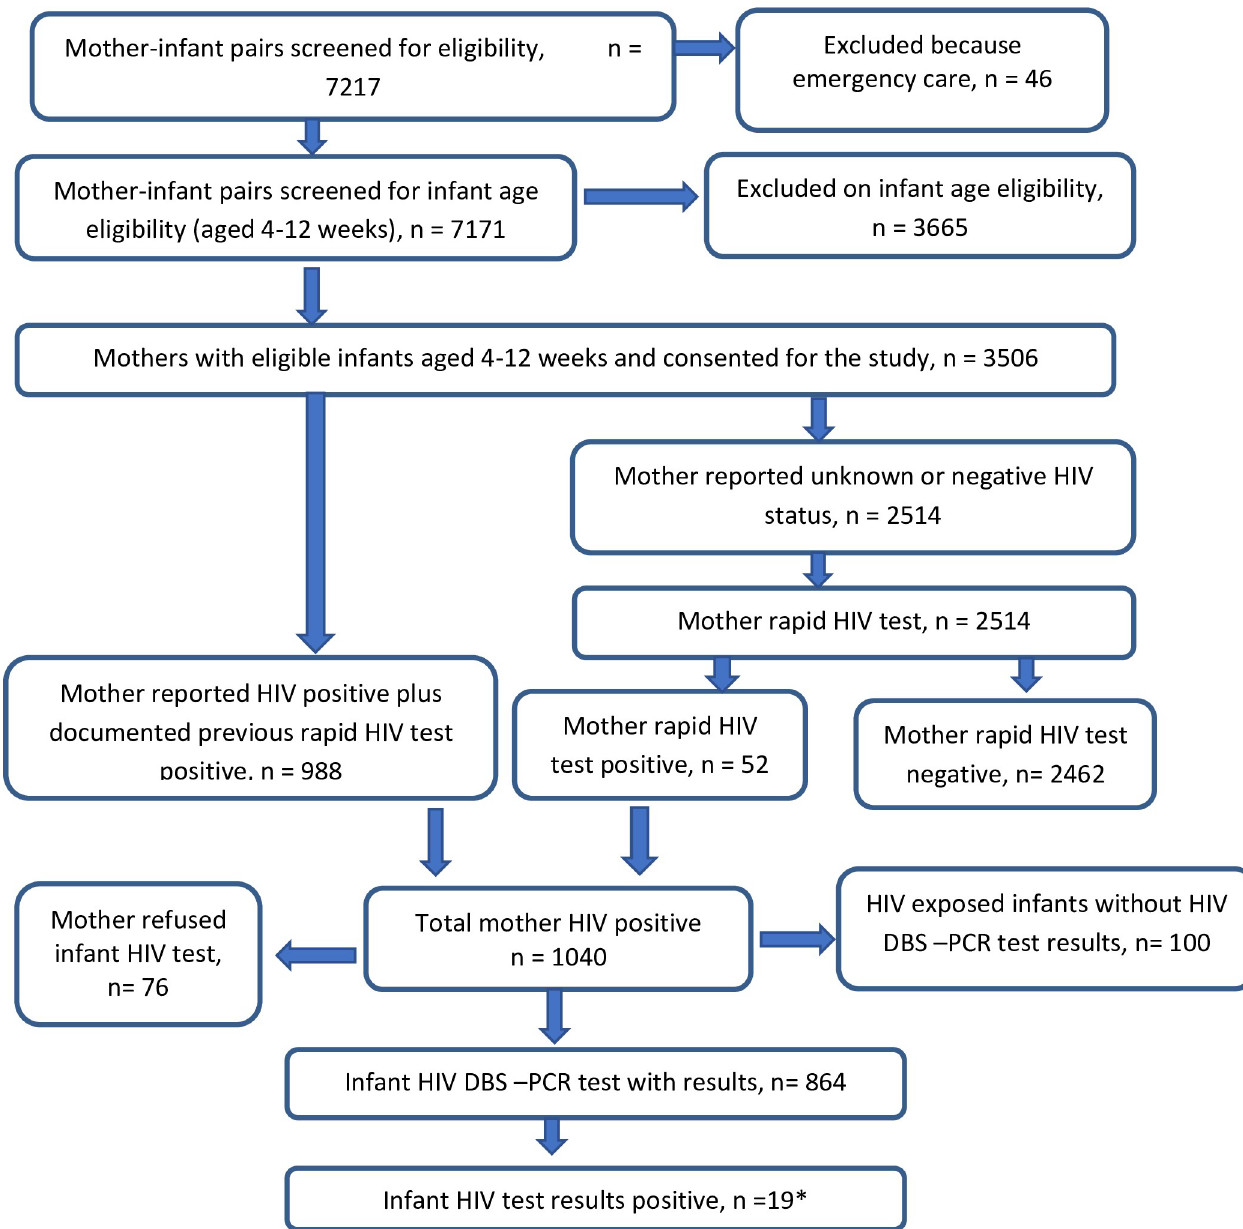
Fig 1. Eligibility and enrolment in Namibia PMTCT survey 2014–2015: Unweighted numbers. � 4 HIV positive infants whose mothers had not provided any PMTCT information were only included in the national (overall) calculation of early MTCT prevalence and excluded in risk factor analysis.